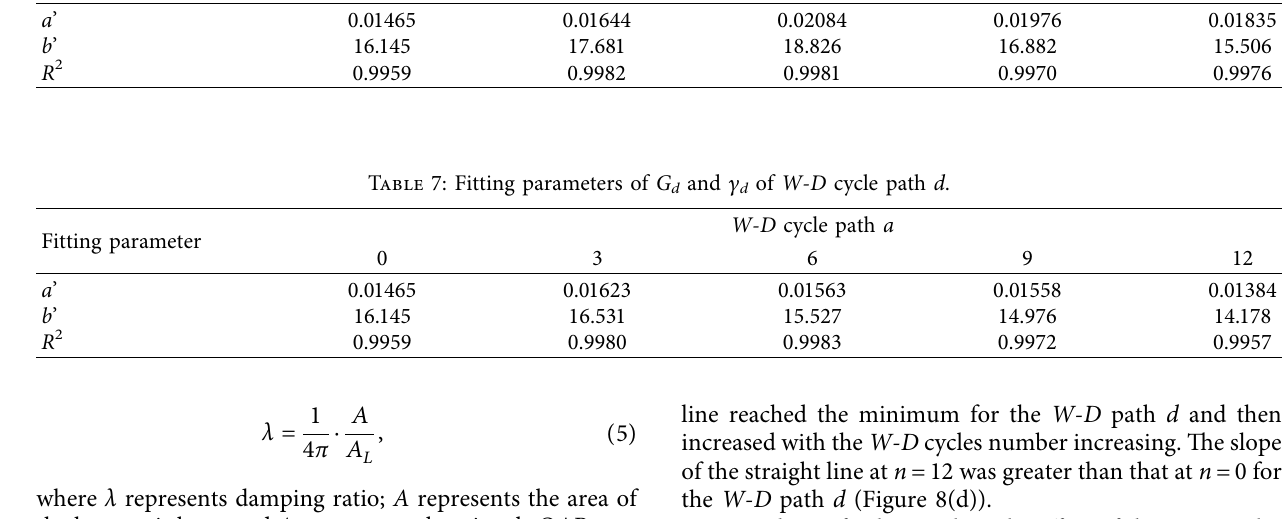
c d and d of W - D cycle path c .